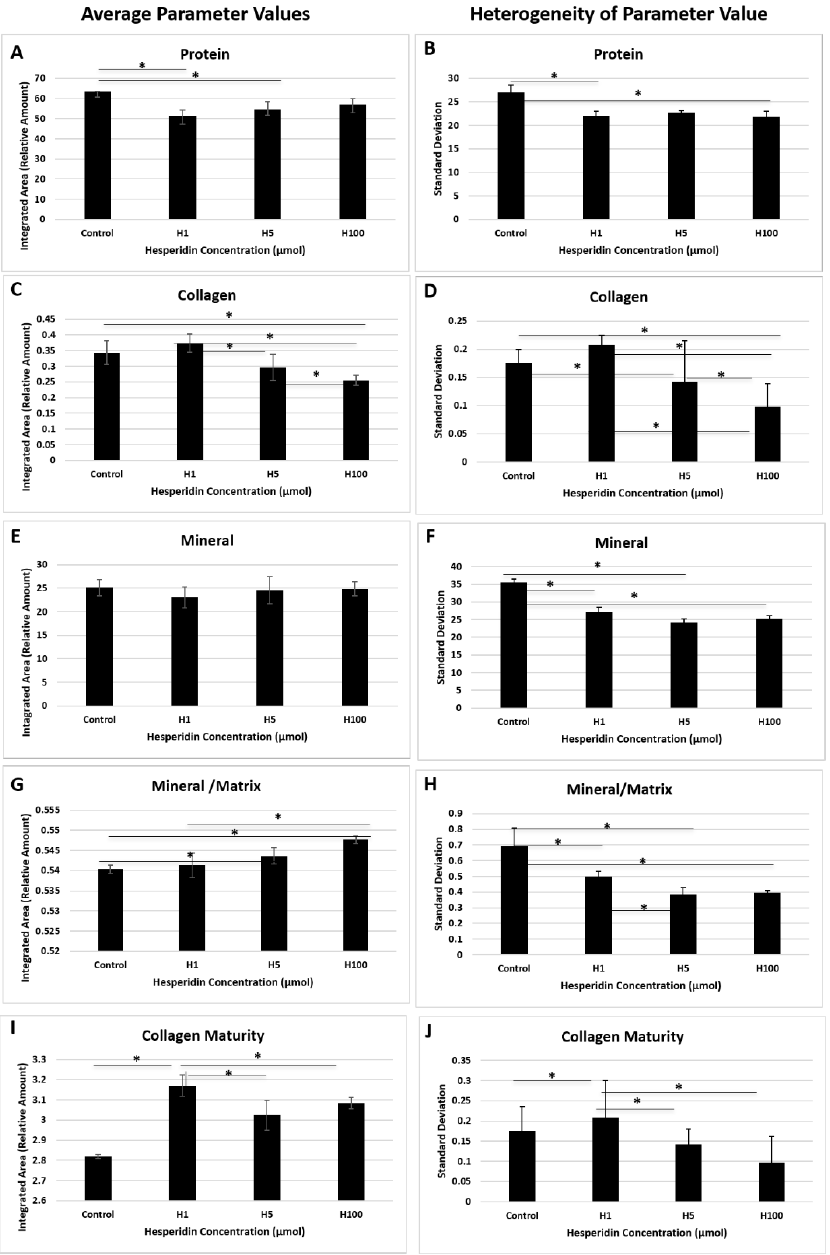
Figure 4. Average FT-IR-derived parameters for control and treated samples demonstrate matrix composition and quality changes. Total protein was affected by hesperidin (H)1 (1 µM) and H5 (5 µM) doses ( A ) and collagen matrix amount was reduced significantly with H5 and H100 (100 µM) doses ( C ) (* represents statistical difference p < 0.05). Standard deviation or heterogeneity plots indicate the variation in matrix composition and quality within the sample. Parameters from H-treated samples were less heterogeneous ( B , D , F , H – J ), i.e., a more homogenous distribution of tissue components. Mineral-to-matrix ratio was significantly increased with higher doses of H ( G ).There were no changes in average mineral content among samples ( E ) ( n =